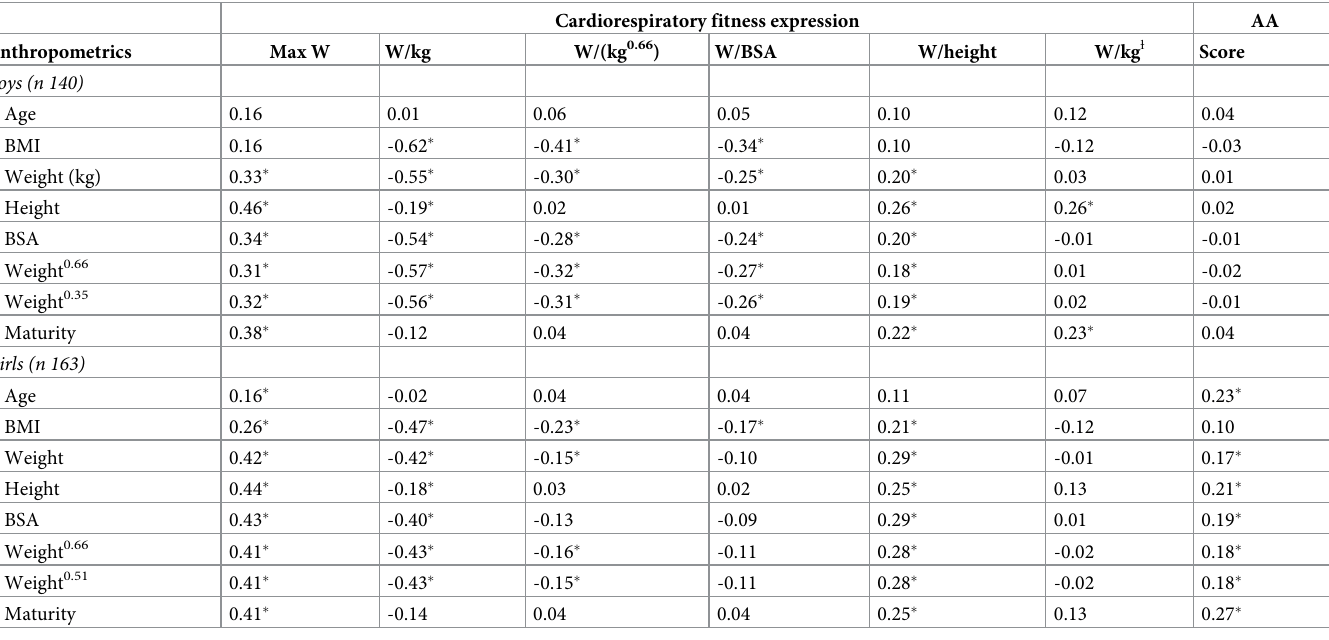
Table 2. Bivariate correlation between key variables. Cardiorespiratory fitness expression